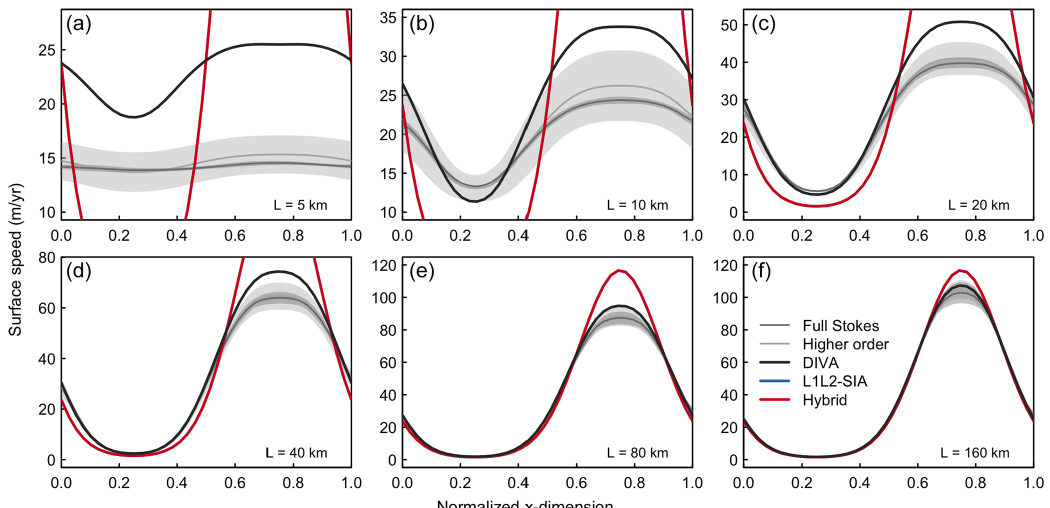
Figure 5. Comparison of velocity solutions for the DIVA (black lines), L1L2-SIA (blue lines) and Hybrid (red lines) solvers as implemented in Yelmo to the full Stokes (dark grey lines and bands) and higher-order (light grey lines and bands) solvers used in the ISMIP-HOM benchmark experiment A (ice flow over a bumpy bed with zero sliding; Pattyn et al., 2008) for six length scales (5, 10, 20, 40, 80 and 160km) in panels (a) – (f) , respectively. The L1L2-SIA and Hybrid solutions are identical, both reducing to the local SIA solution in the absence of sliding (thus the lines